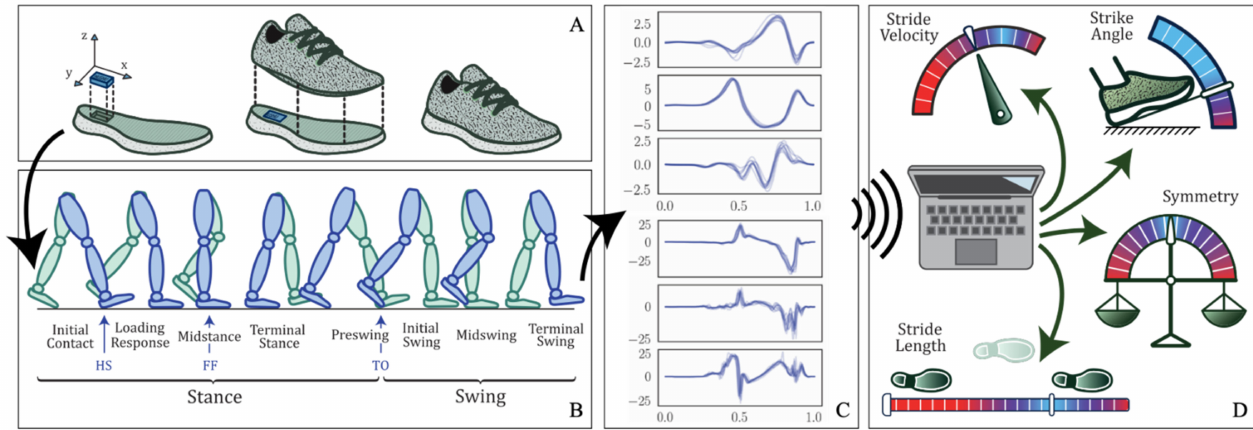
Figure 1. Graphical illustration of the Nushu system. ( A ) The sensor units are inserted in the outsole of the shoe; the upper part is glued so as to seal the shoe. ( B ) Gait phases during a full gait cycle. ( C ) Signal examples from the sensors. ( D ) Gait parameters generated by Nushu